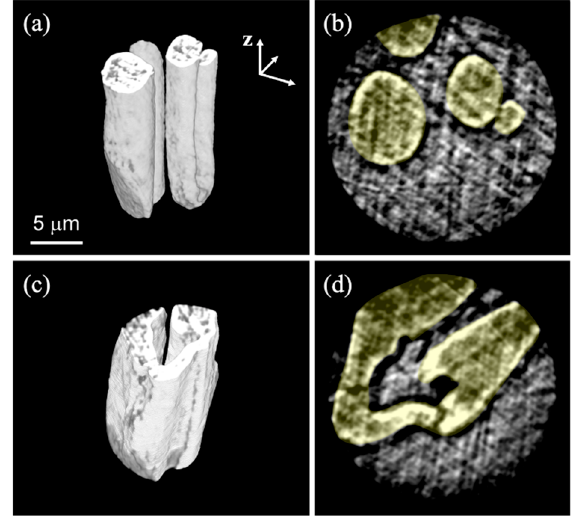
Figure 6. 3D TXM reconstructed image and the slice plane along z -direction of the N95 mask in ( a ) and ( b ); those of the 3M filter in ( c ) and ( d ), respectively.